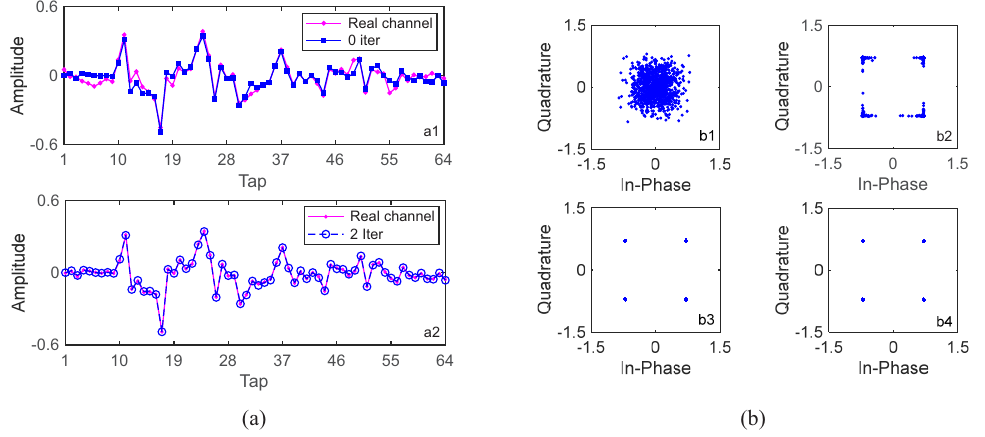
Figure 8. Estimated channels and constellations of a block of 1024 information bits with S256 in simulations at SNR = 13 dB. ( a1 ) Channel estimate of one segment without iteration; ( a2 ) channel estimate of one segment after 2 iterations; ( b1 ) constellations after 0 iteration; ( b2 ) constellations after 1 iteration; ( b3 ) constellations after 2 iterations; ( b4 ) constellations after 3